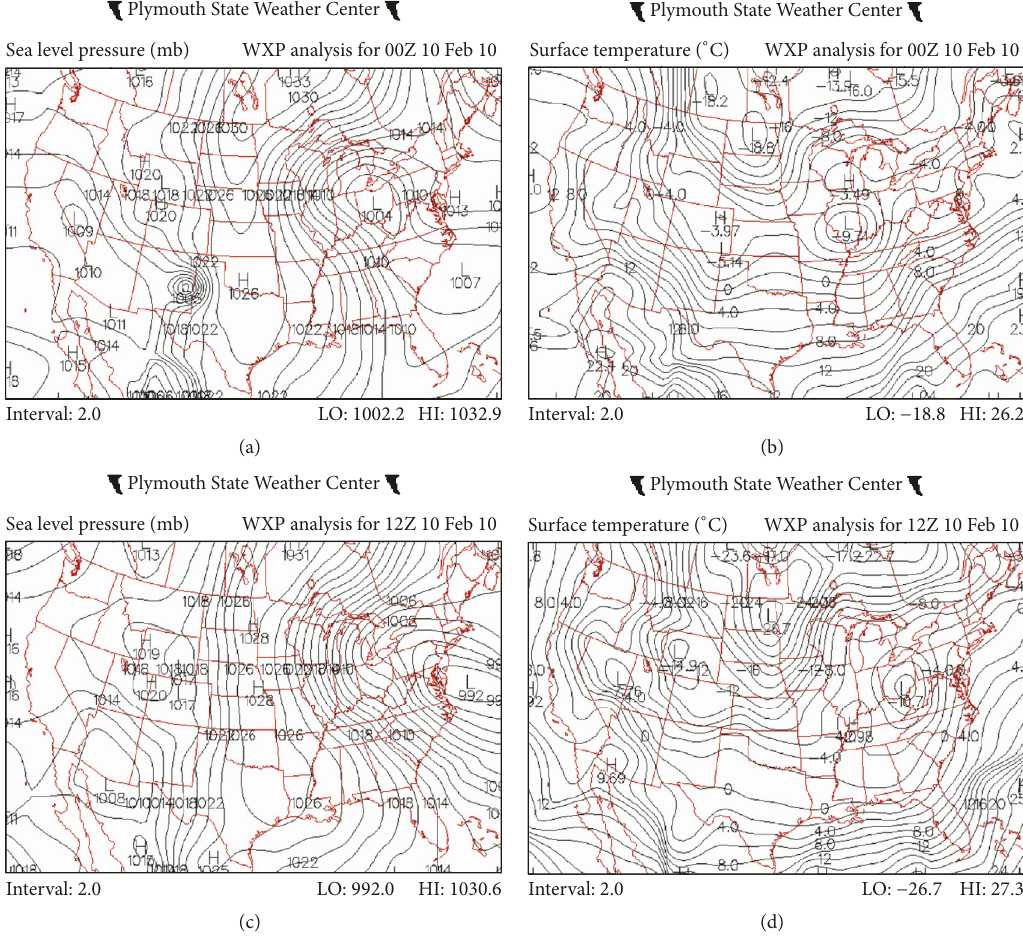
Figure 5: Plymouth State Weather Center sea level pressure and surface temperature (a-b) valid for 0000 UTC 10 February and (c-d) valid for 1200 UTC 10 February